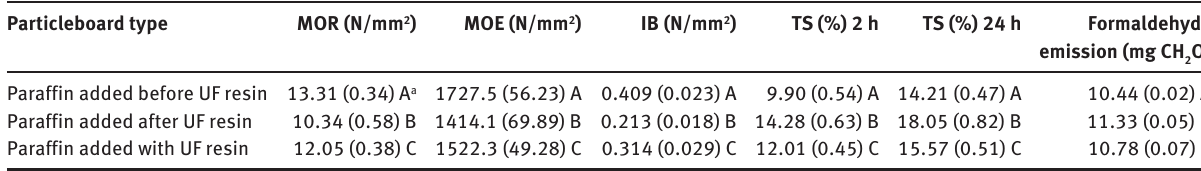
Table 2 The average values of mechanical and physical properties. Particleboard